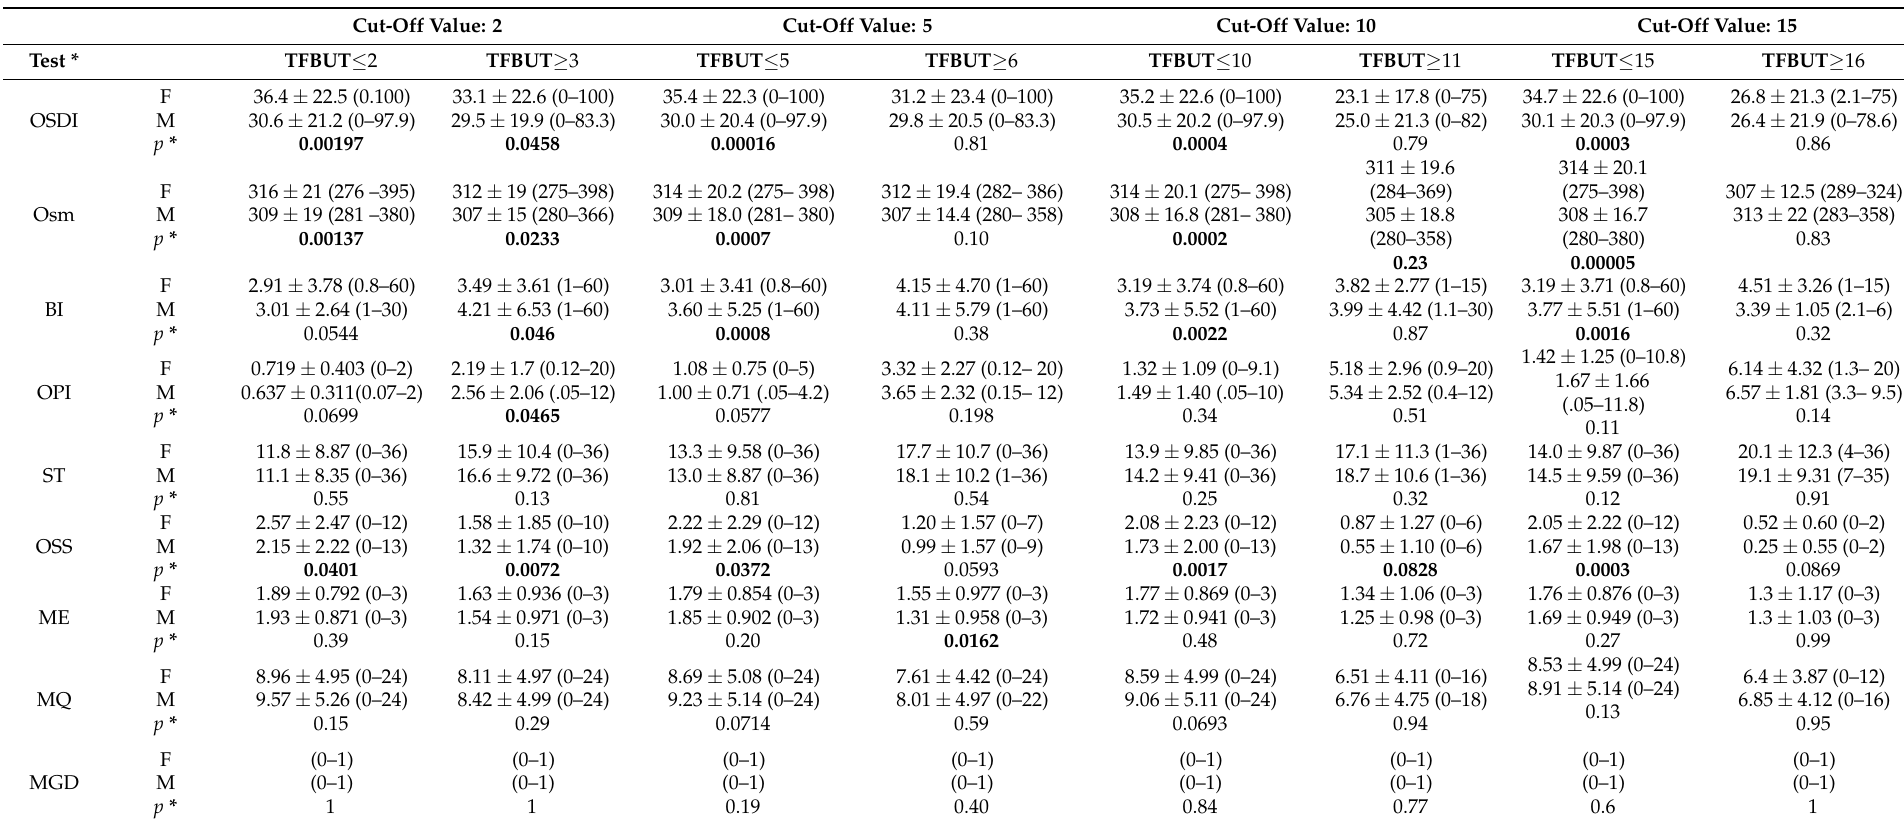
Table 5. Sex difference for each clinical parameter, and in each group below and above the four defined cut-off values (2, 5, 10, and 15) for pathological DED measured by TFBUT (mean ± standard deviation, Mann–Whitney test of comparison for continuous variables and Chi-Square test for dichotomous one—MGD). Cut-Off Value: